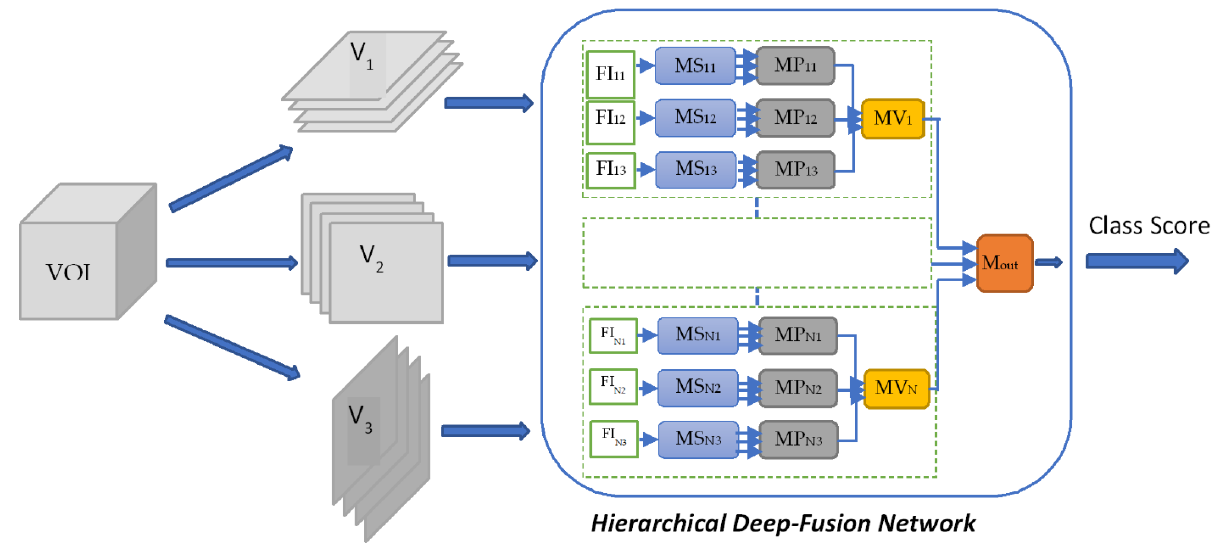
Figure 1. The proposed hierarchical deep-fusion framework.